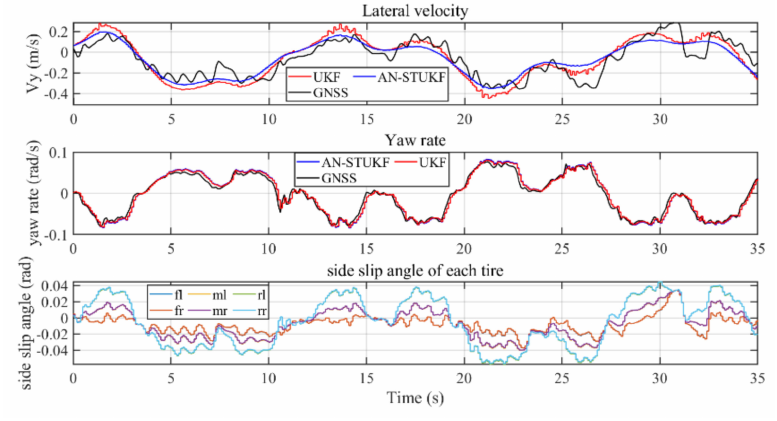
Figure 17. The lateral state when a skid-steered wheeled vehicle turns in a large radius.